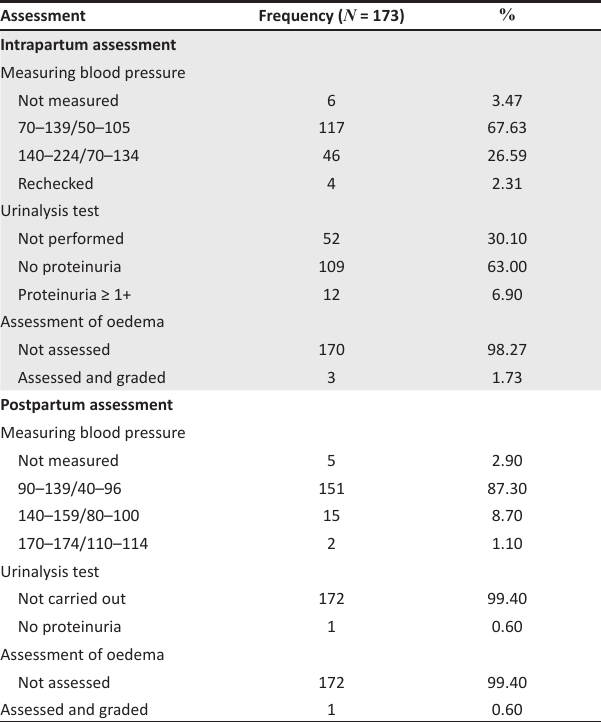
TABLE 2: Intrapartum and postpartum assessment of hypertension among teenagers. Assessment